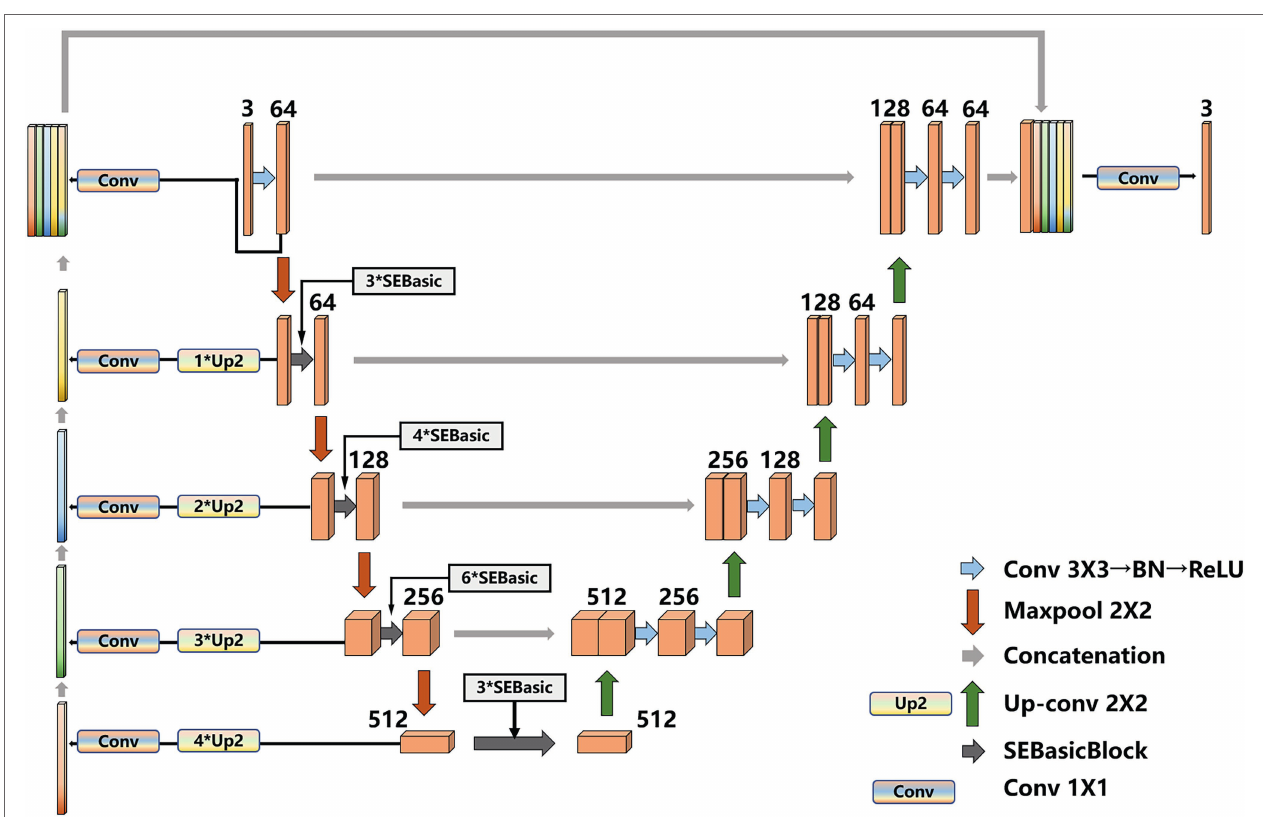
FIGURE 5 | Improved